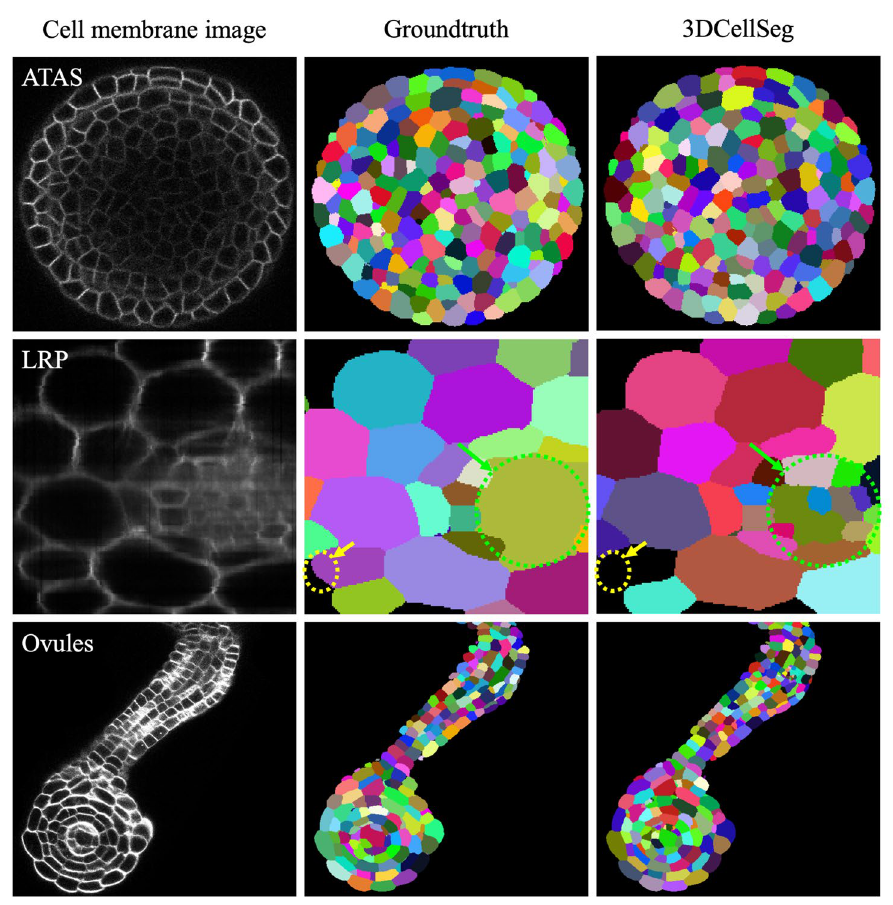
Figure 3. 3DCellSeg performance on the ATAS, LRP, and Ovules datasets. [Note: Different cell instances were randomly assigned different colors. The LRP dataset images are annotated: the yellow circle shows where 3DCellSeg has made a mistake and the green circle shows that 3DCellSeg can segment cells that were not labelled in the ground truth. The cellular images were generated by Python Matplotlib (https:// matpl otlib. org) using the ATAS 49 , LRP 50 , and Ovules 51